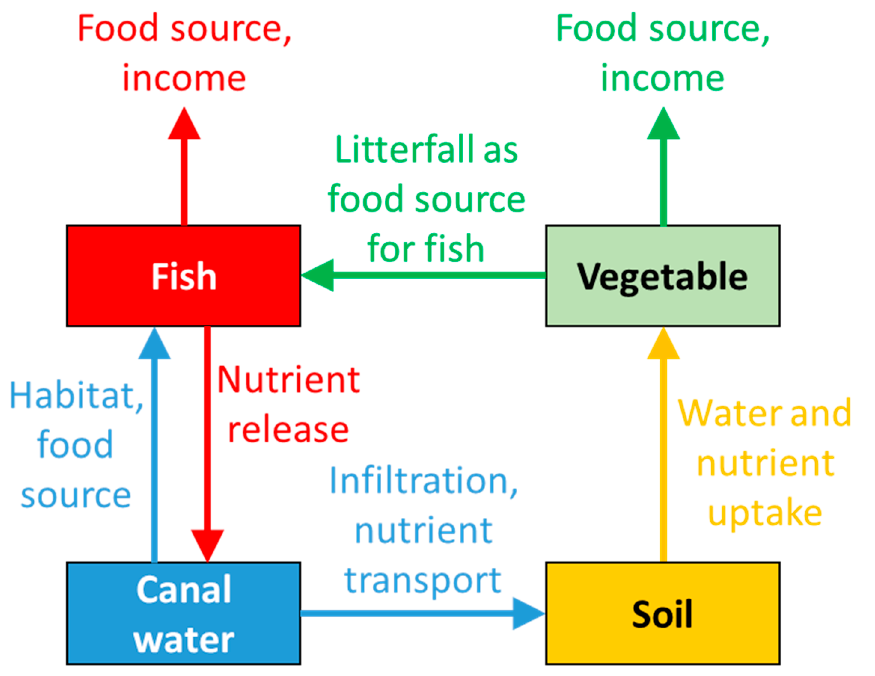
Figure 1. Potential benefits of integrated fish and cucumber production.